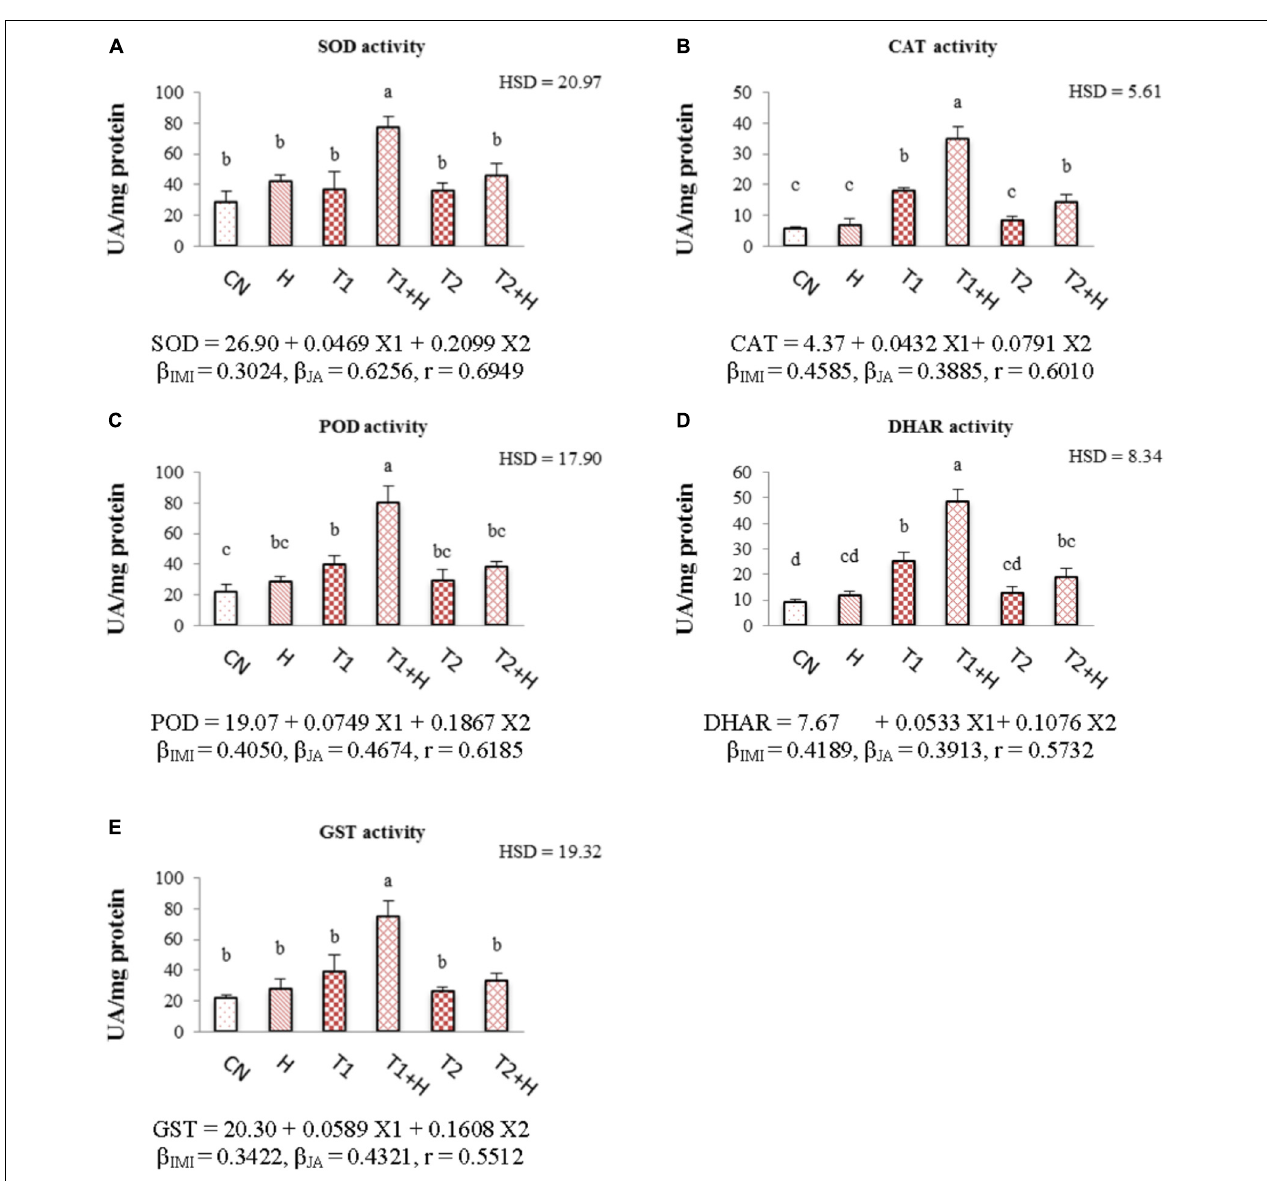
FIGURE 5 | Effect of JA seed soaking on the activities of antioxidative enzymes in B. juncea seedlings under IMI stress. Data shown here are mean ± SD ( n = 3). Means with same letters are not significantly different from each other, IMI, imidacloprid (X1); JA, jasmonic acid (X2); T1, 200 mg · L − 1 (IMI); T2, 250 mg · L − 1 (IMI); H, 100 nM (JA); r, multiple correlation coefficient. β = β -regression coefficient. A = SOD; B = CAT; C = POD; D = DHAR; E =